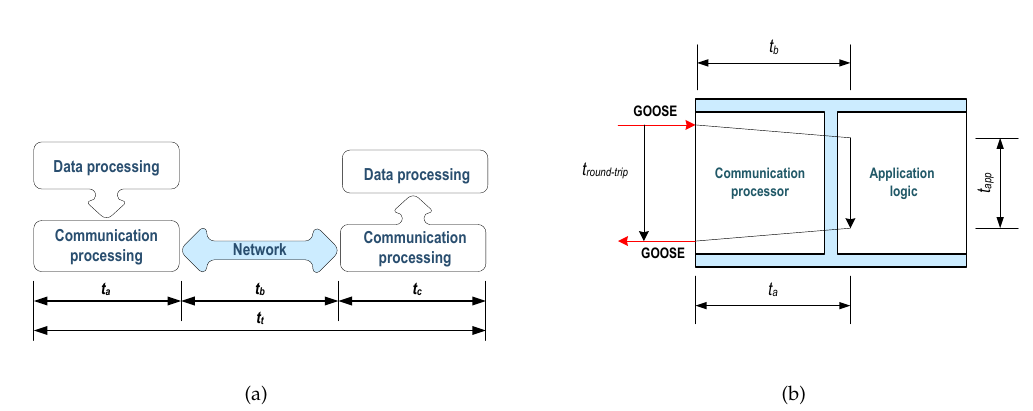
Figure 15. Methods for performance measurements according to IEC 61850: ( a ) Definition of overall transfer time [56]; ( b ) Round-trip time